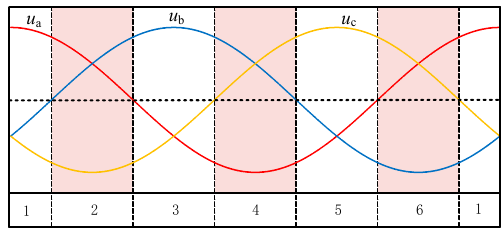
Figure 2. Topology of IMC.